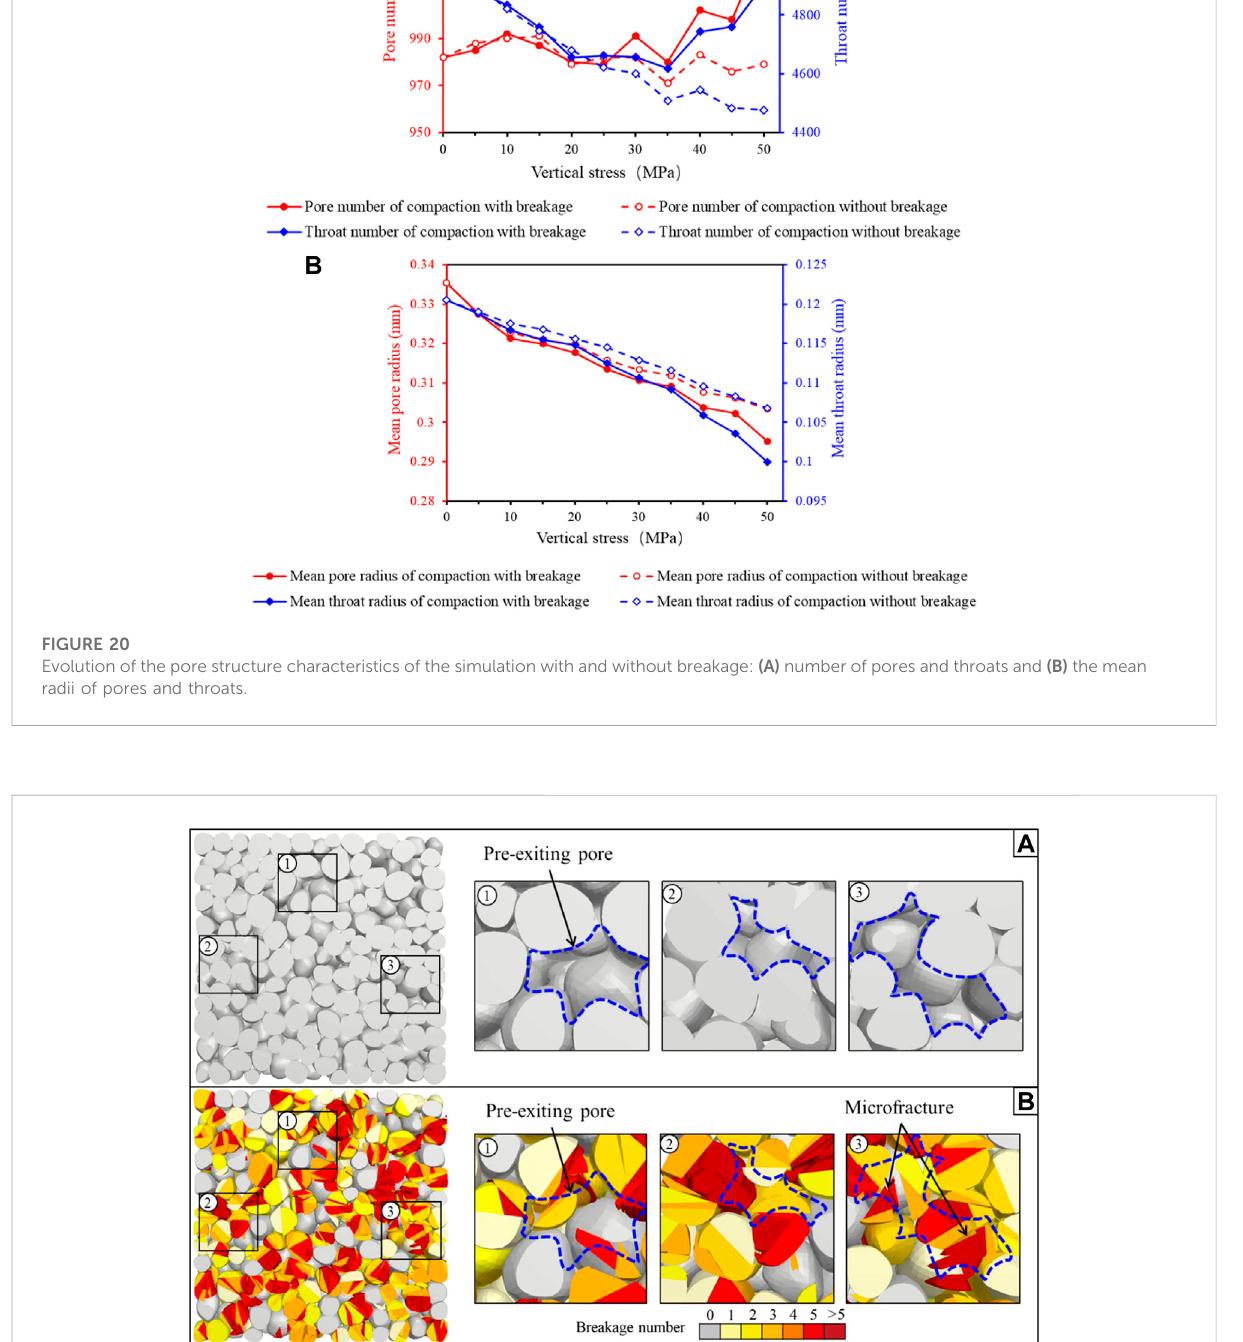
Frontiers in Earth